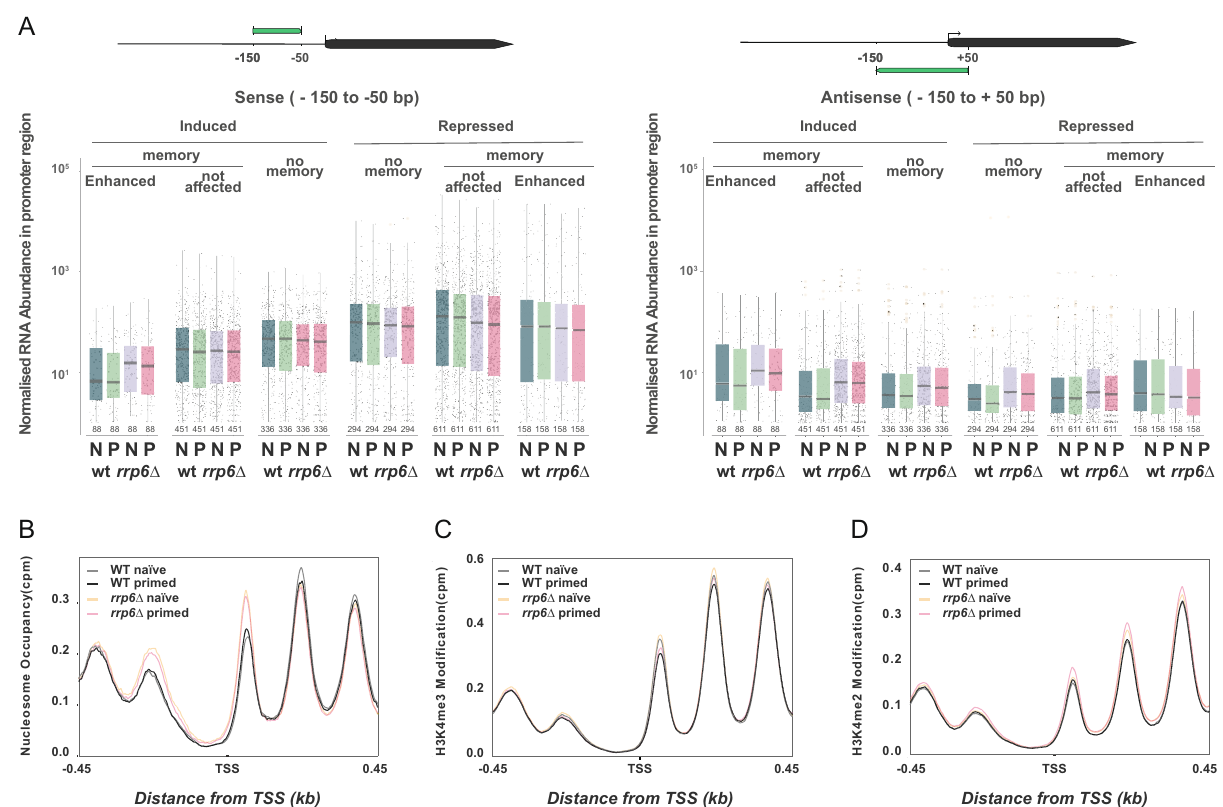
Fig. 3 | Non-coding transcription and chromatin organization do not explain differences between naive and primed states. A RNA-Seq coverage of unan- notated ncRNA transcription surrounding coding genes ’ transcription start sites (TSS) (i.e., overlapping the promoter region). Average RNA coverage at the pro- moterregiononthesensestrand( − 150to − 50bpinrespecttoTSS)isshownonthe leftandantisensetranscription( − 150to+50bpwithrespecttoTSS)isshownonthe right. Boxplots for wild-type t 0 naive (N in cyan), wild-type t 0 ’ primed (P in green), rrp6 Δ t 0 naive (N in purple), and rrp6 Δ t 0 ’ primed (P in pink) are shown. mRNA